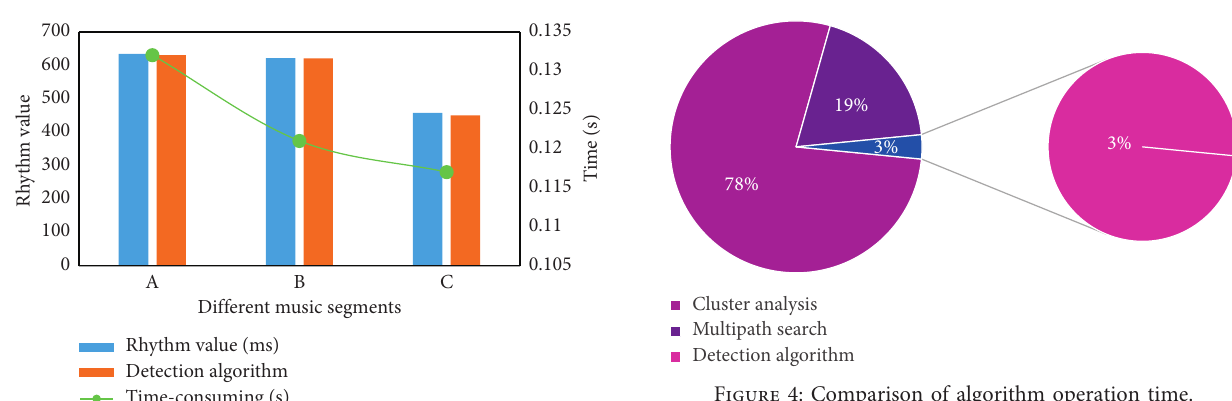
Figure 3: Comparison of rhythm points tracked by the track and actual rhythm